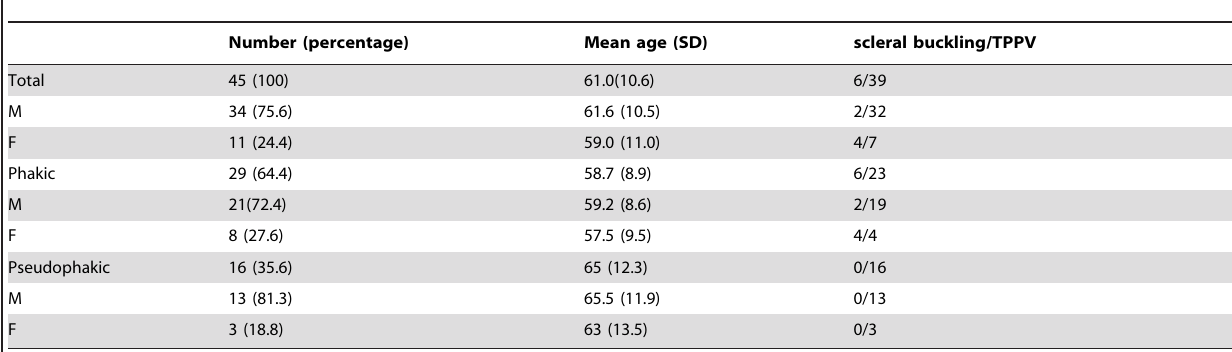
Table 1. characteristics of the RRD